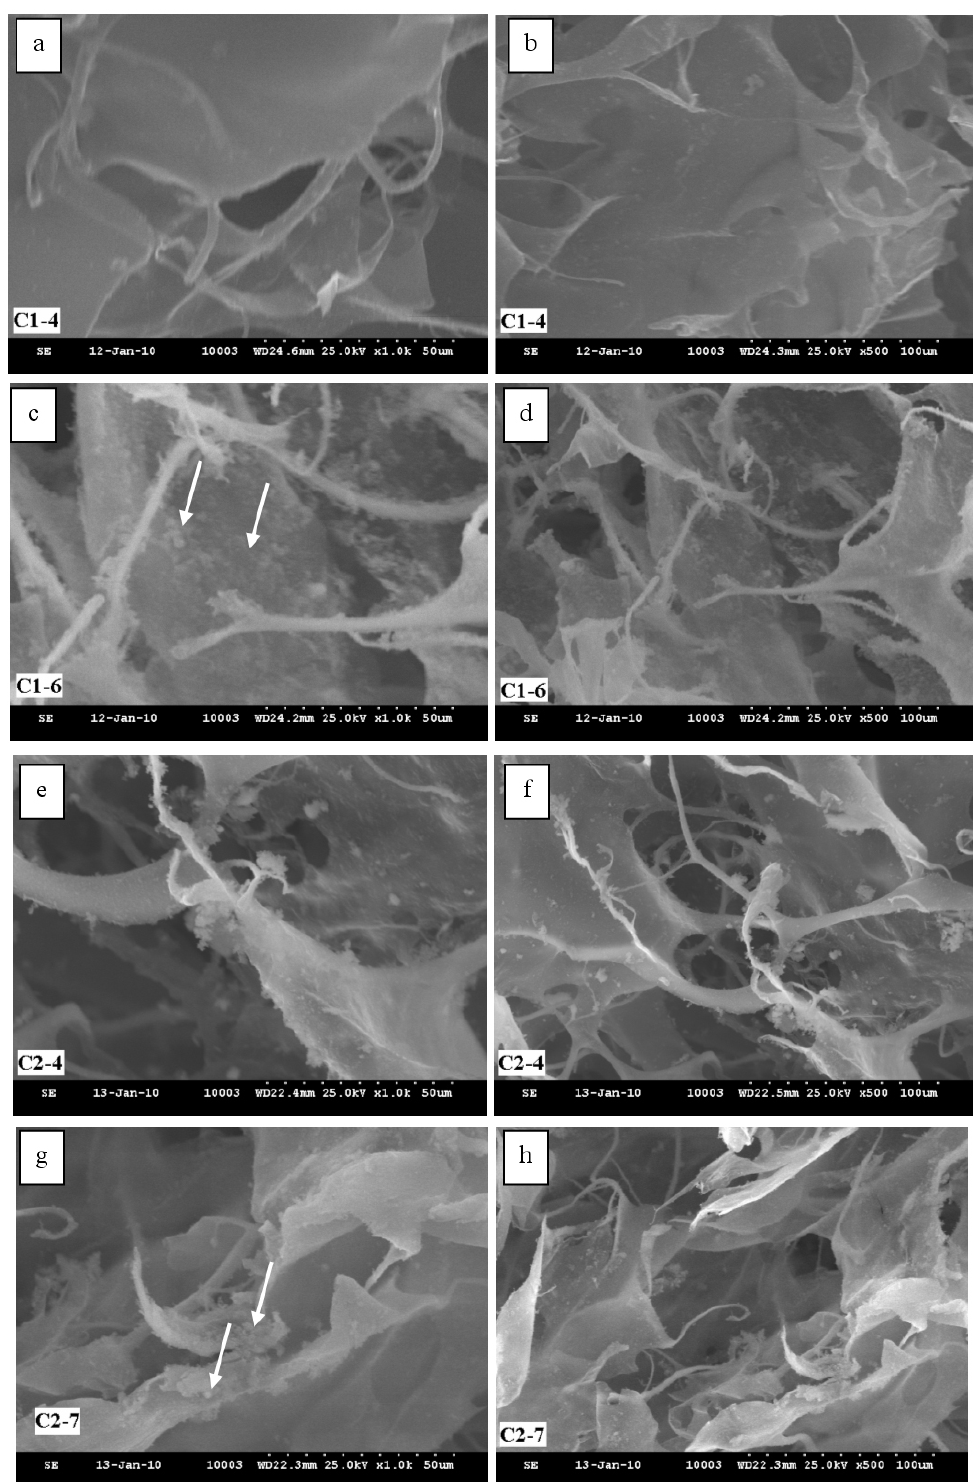
Figure 2. Characteristic SEM images recorded for some COLL/HA composite materials obtained by LbL, at different HA precursors’s concen tration and 1000 and respectively 500x magnification (arrows indicate HA